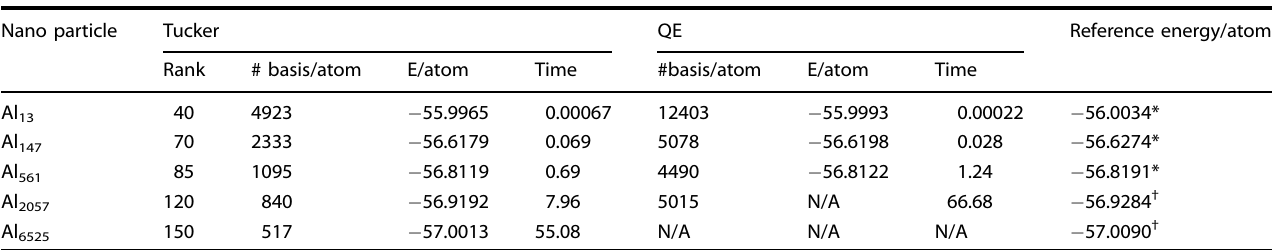
Table 1. Comparison of the computational performance for Aluminum nano-particles.